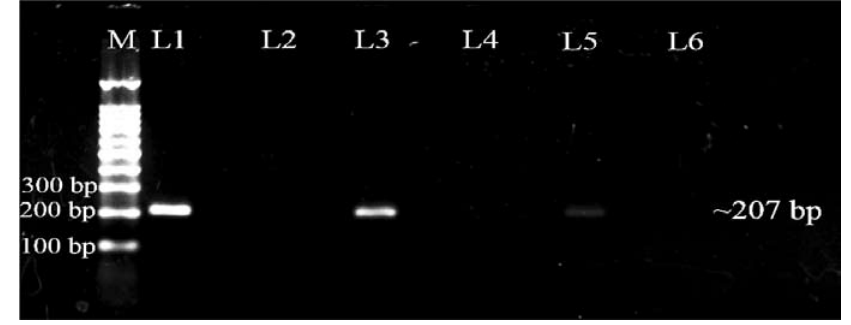
Fig.2. Identification of Haemoproteus columbae by detection of cytb gene by PCR M: DNA ladder L1: Positive control. L2, L3, L4, L5: Samples. L6: Negative